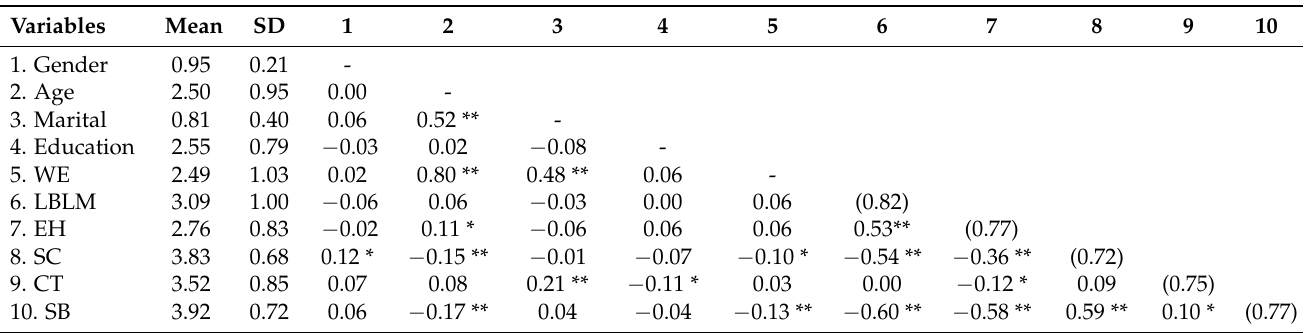
Table 4. Descriptive statistics and correlations among variables (N =